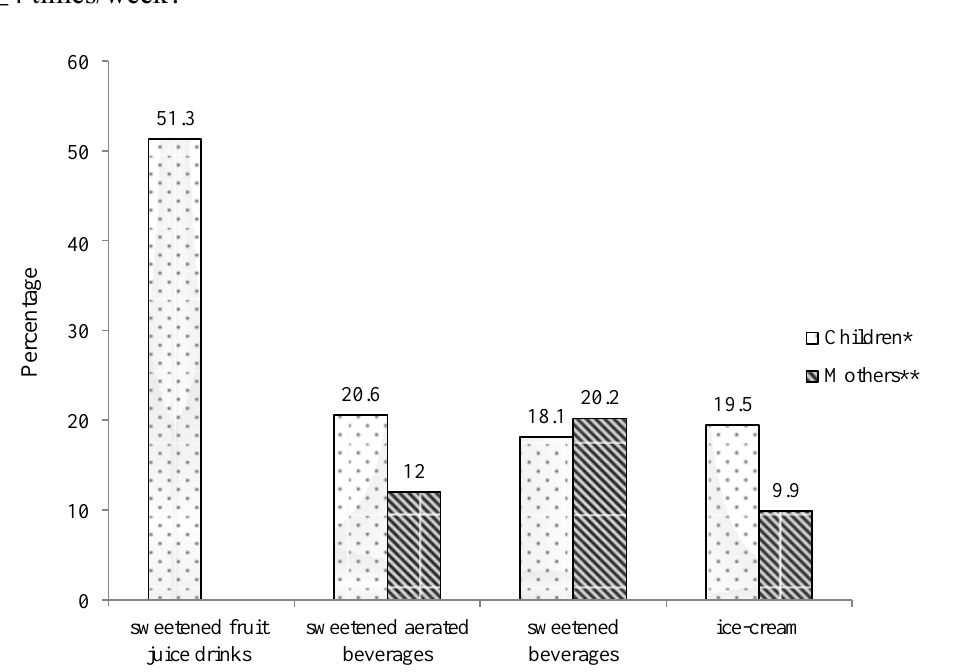
Figure 8. Percentage of children and mothers consuming different sweetened food items ≥4